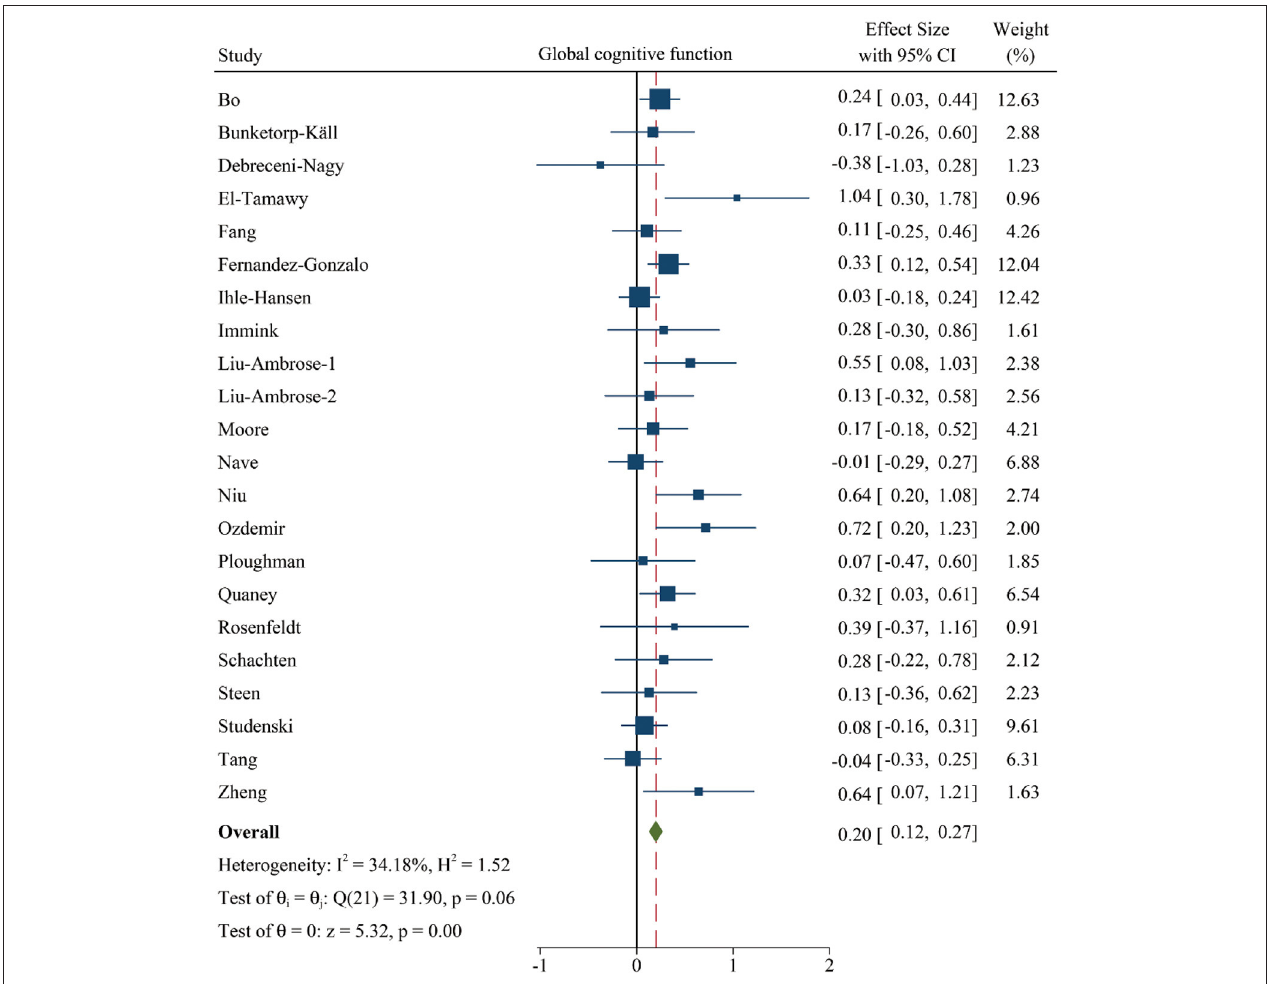
FIGURE 2 | Forest plot of meta-analysis in the effect of PA on global cognitive function. Positive values of pooled effect size represented that PA improved cognitive performance. CI , confidence interval; PA, physical activity.